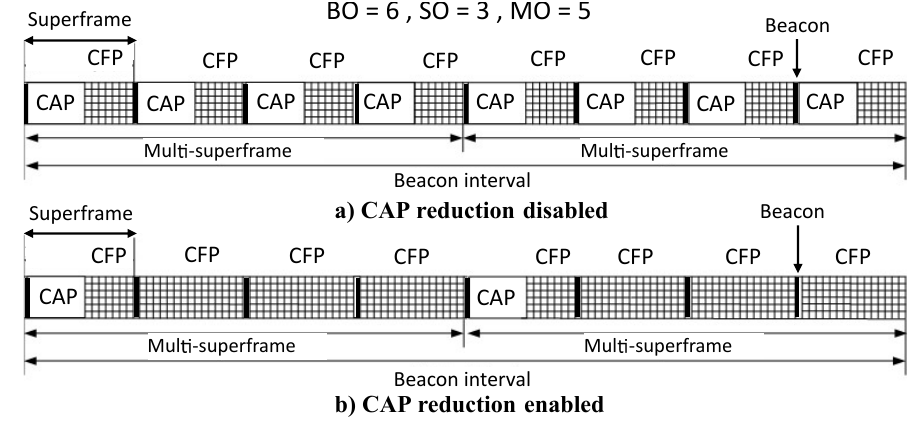
Figure 1. DSME multi-superframe